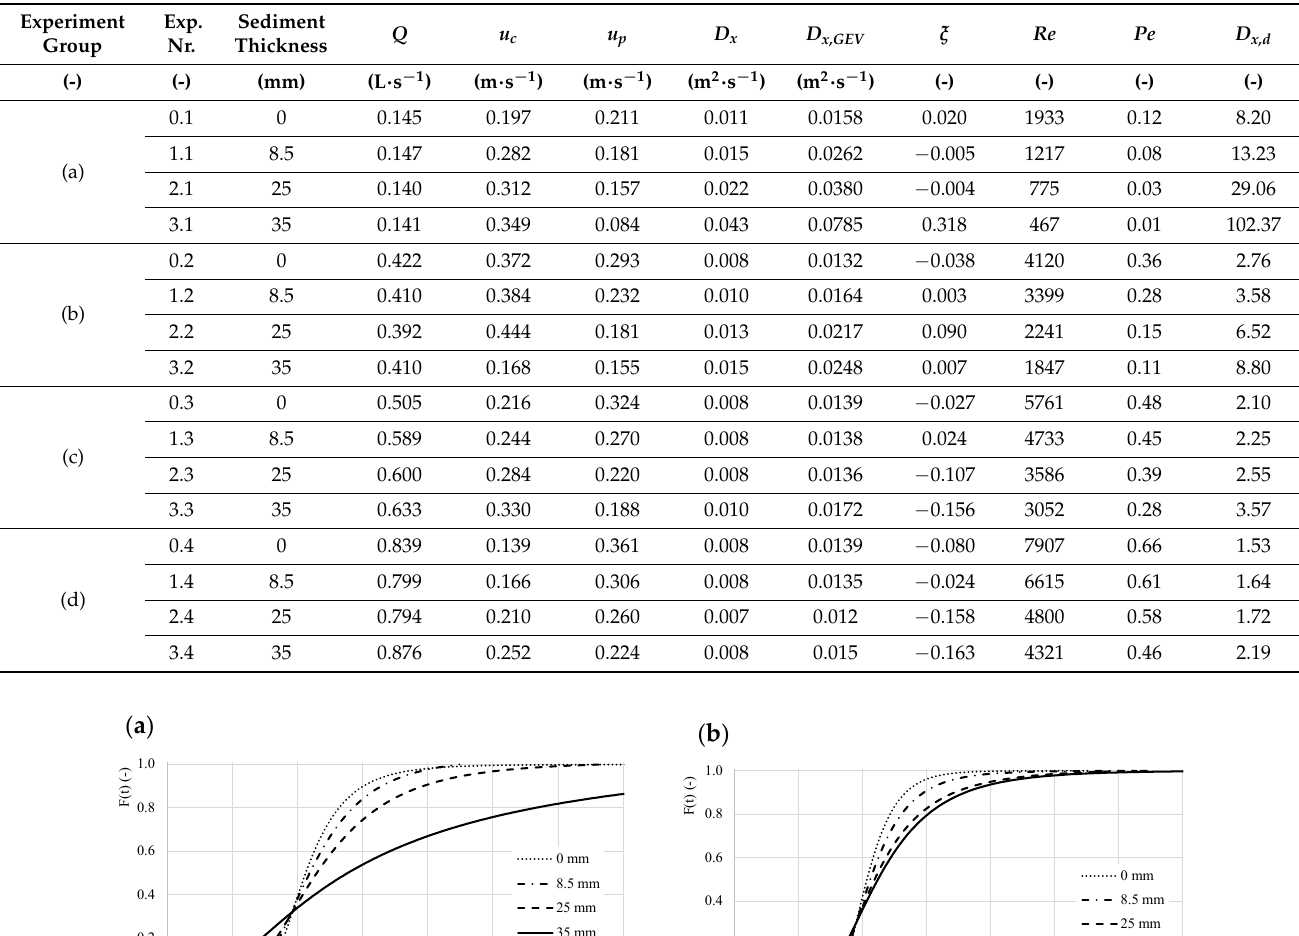
Figure 8 in form of the cumulative residence time distribution (CRTD). The displayed curves represent the statistically processed and averaged approximations for particular experiments. Table 2. Experiment groups.